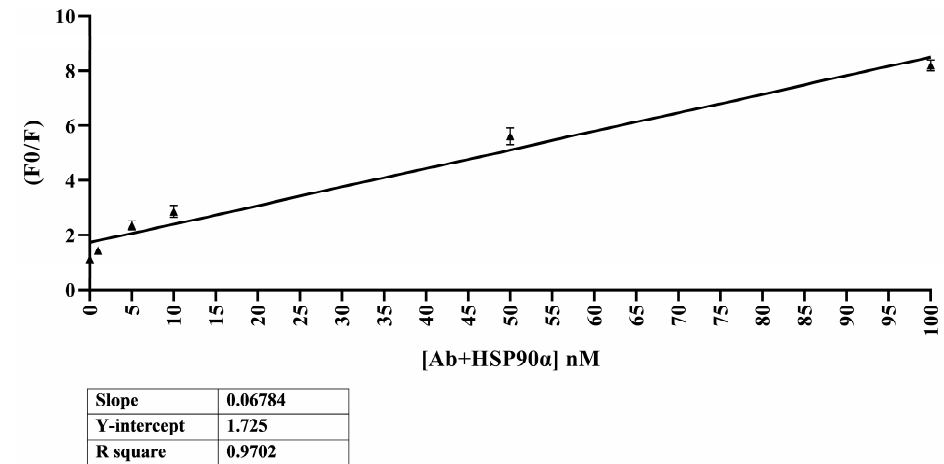
Figure 6. Masking of Sav-QDs plotted in Stern–Volmer plot as a function of (F0/F) versus HSP90 α concentration ranging from 100 to 1 nM. F0 and F are fluorescence intensities of Sav-QDs after adding antibody and HSP90 α . K SV is evaluated to be 0.06784 nM − 1 with linear data regression (r 2 = 0.97). LoD and LoQ of the assay are 5.18 nM (0.45 µg/mL) and 15.2 nM (15.62 µg/mL). These values are nearby the EC 50 value of biotin-ATP and HSP90 α binding assay.